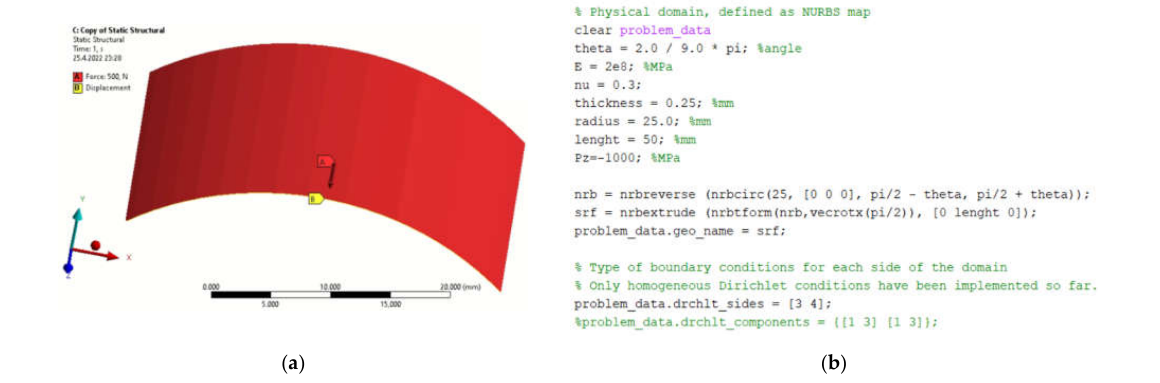
Figure 9. Geometric characteristics, boundary conditions and material properties ( a ) FEM program; ( b ) MATLAB.